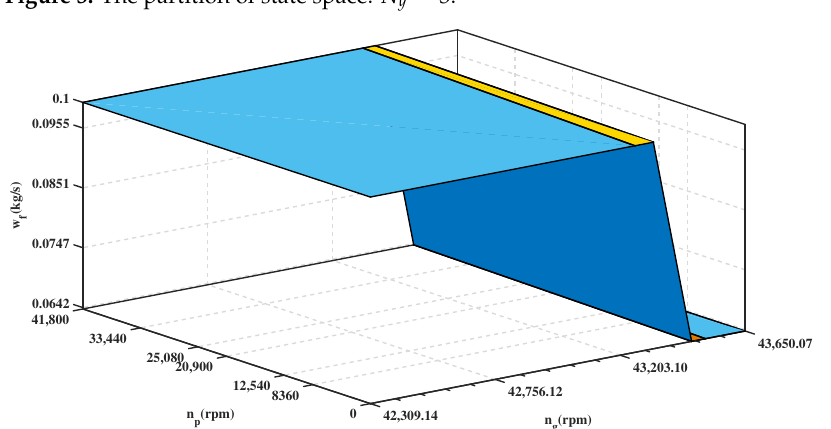
Figure 4. Affine function relationship between controller and state partition: N y = 3.